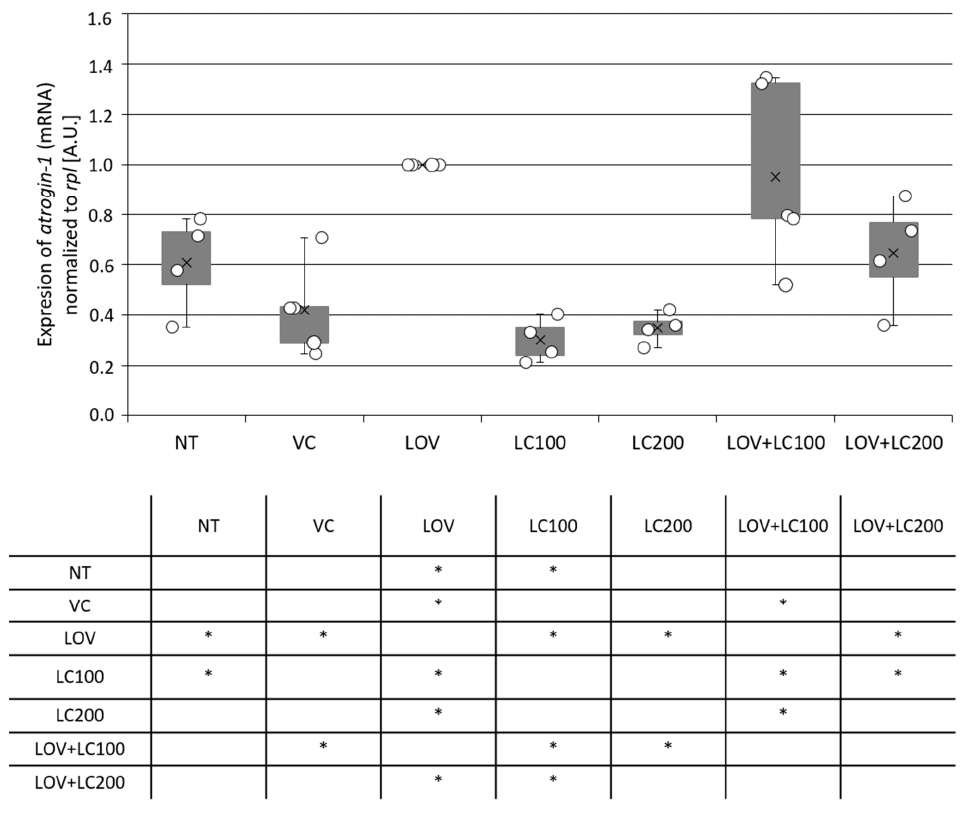
(0.5 μ M lovastatin, LOV; 0.5 μ M lovastatin and 100 μ M L ‐ carnitine, LOV+LC100; 0.5 μ M lovastatin and 200 μ M L ‐ carnitine LOV+LC200) groups. Expression of atrogin ‐ 1 mRNA was normalised to (0.5 µ M lovastatin, LOV; 0.5 µ M lovastatin and 100 µ M L-carnitine, LOV+LC100; 0.5 µ M rpl13a (ribosomal protein L13a). A.U., arbitrary unit. Error bars show the standard deviation. The tables below indicate the pairwise comparison between atrogin ‐ 1 expression levels in investigated groups. Statistically significant differences are indicated with *; * p < 0.05 (Student’s t ‐ test). The experiment was performed 3 times (with 25–30 individuals in each investigated group).